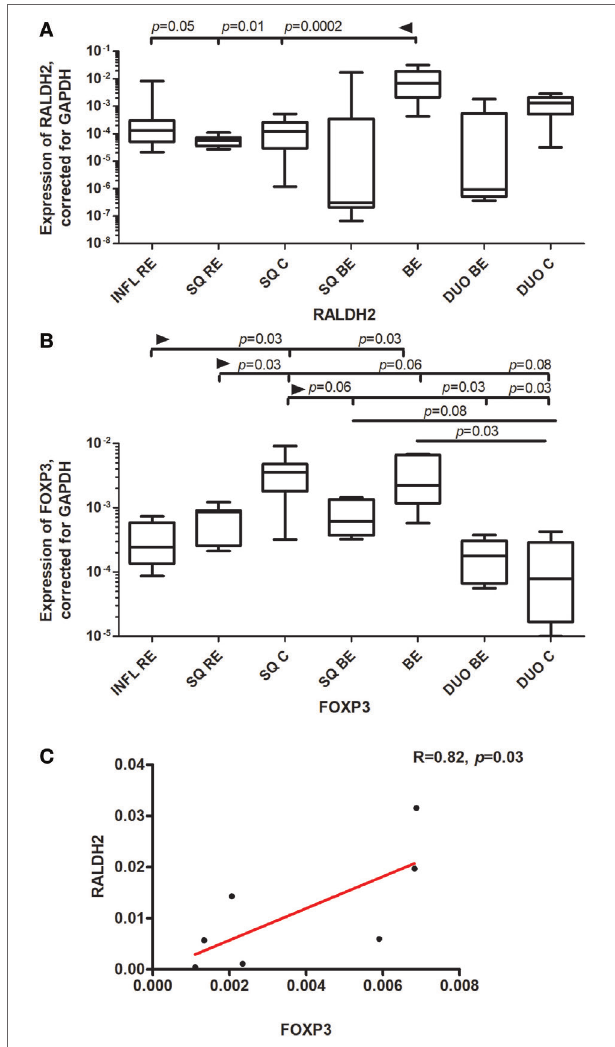
FigUre 5 | High expression of RALDH2 and FOXP3 in Barrett’s esophagus (BE) tissue. Panel (a) depicts expression of RALDH2 by real-time (RT)-PCR performed on a total of: inflamed reflux esophagitis (RE) biopsies (INFL RE, n = 9), non-inflamed squamous esophageal epithelium from RE patients (SQ RE, n = 9), squamous esophageal epithelium from controls (SQ C. n = 12), squamous esophageal epithelium from BE patients (SQ BE, n = 10), BE biopsies (BE, n = 11), duodenal biopsies from BE patients (DUO BE, n = 10), and duodenal biopsies from controls (DUO C, n = 5). Panel (B) depicts expression of FOXP3 by RT-PCR performed on a total of: inflamed RE biopsies (INFL RE, n = 6), non-inflamed squamous esophageal epithelium from RE patients (SQ RE, n = 7), squamous esophageal epithelium from controls (SQ C, n = 12), squamous esophageal epithelium from BE patients (SQ BE, n = 7), BE biopsies (BE, n = 8), duodenal biopsies from BE patients (DUO BE, n = 5), and duodenal biopsies from controls (DUO C, n = 5). In panels (a,B) data were analyzed, using the Kruskal–Wallis test (RALDH2: p < 0.0001, FOXP3: p < 0.0001). RALDH2 expression and FOXP3 expression was corrected was corrected for GAPDH, 2 −Δ CT ± SEM. p -values from comparing individual groups were obtained by using Mann–Whitney U test in case of individual groups, and Wilcoxon signed rank test for different tissue types from the same patient. Adjustment for multiple comparison was conducted by Benjamini– Yekutieli method. In panel (c) , correlation and linear regression (red line) between expression of FOXP3 and RALDH2 in BE biopsies are shown, R (correlation coefficient) = 0.82, p = 0.03. The Spearman correlation was conducted as there was no normal distribution of